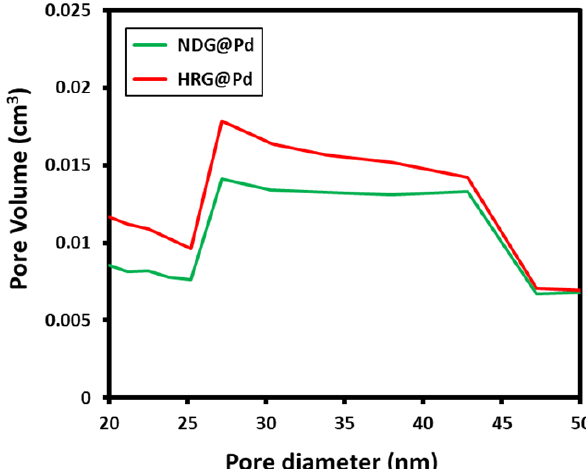
Figure 6. Pore size distribution of the highly reduced graphene-based palladium nanocatalyst (HRG@Pd) and the nitrogen-doped graphene-based palladium nanocatalyst (NDG@Pd).